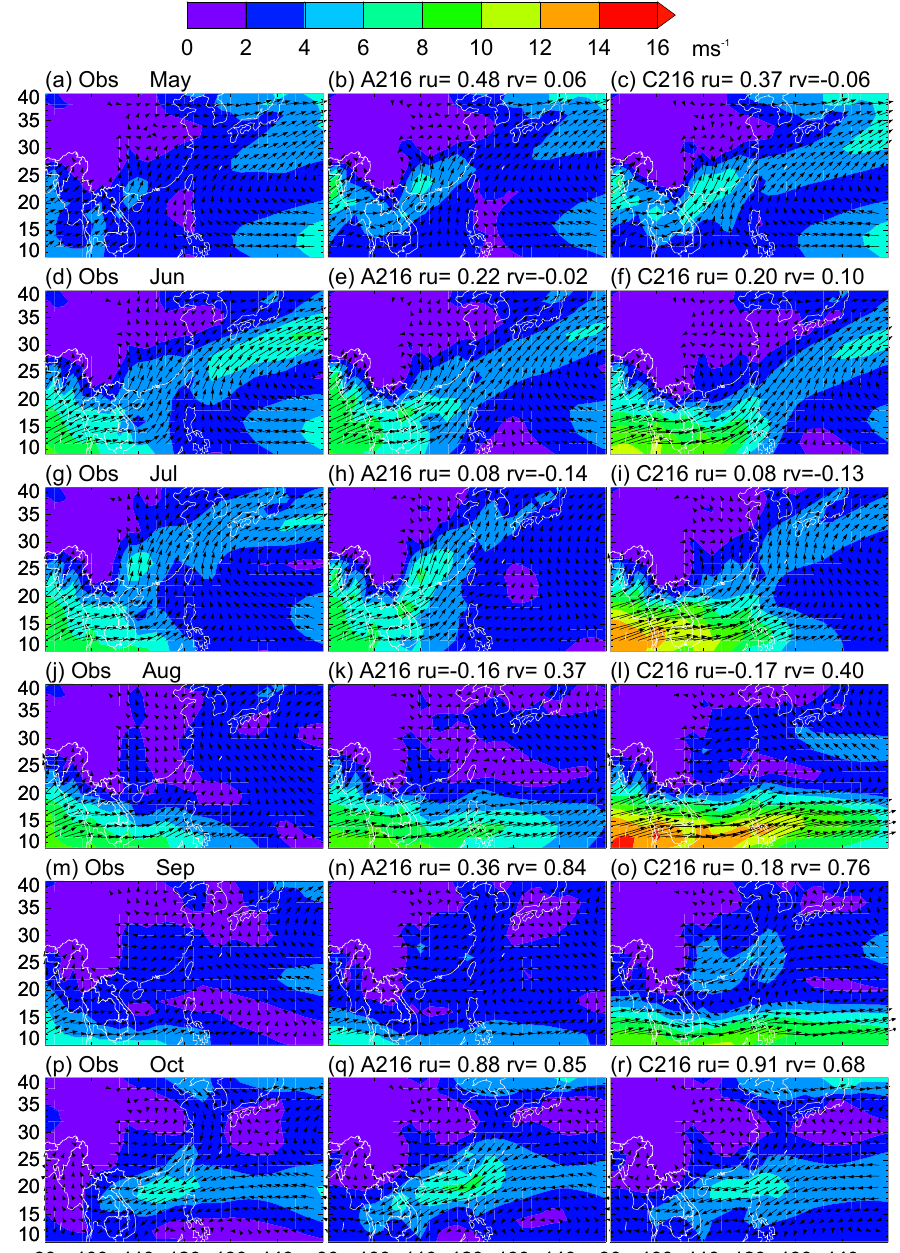
Figure 2. Climatological monthly mean 850hPa wind for observations (left), A216 (middle), and C216 (right). Data were first interpolated to a 2 ◦ × 2 ◦ grid. Shading shows the absolute horizontal wind velocity. Linear pattern correlation coefficients between simulated and observed zonal and meridional wind are denoted by ru and rv,